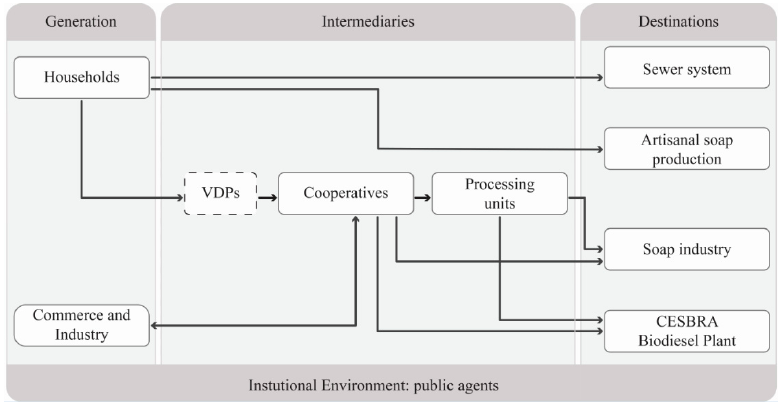
Figure 2. Waste Cooking Oil reverse supply chain in the Region of Médio Paraíba Fluminense.